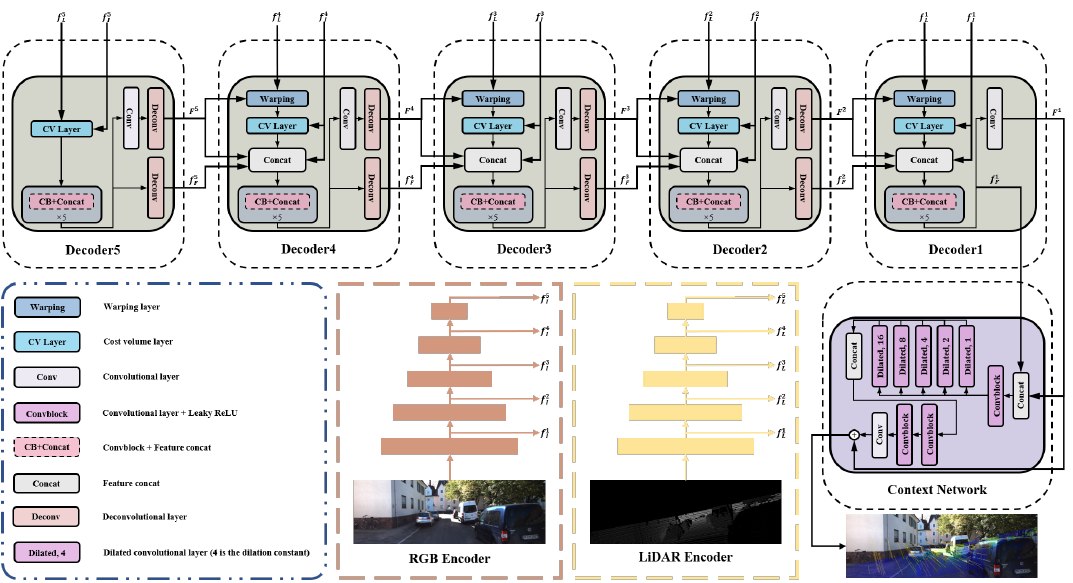
Figure 3. The architecture of our proposed calibration network